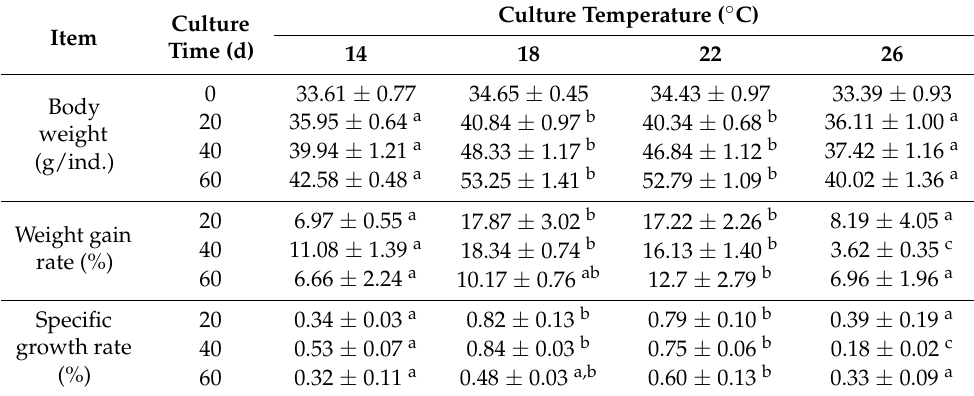
Table 1. Body weight and weight gain rate of juvenile Percocypris pingi at different temperatures. Significant differences in means between the four culture temperature groups are indicated using distinct shoulder letters in the same row ( p <